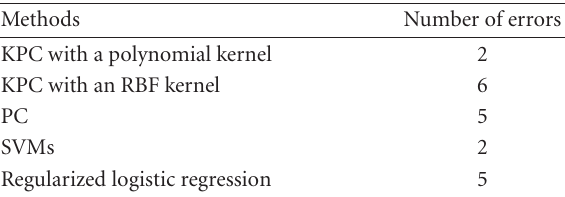
Table 3. Comparison for